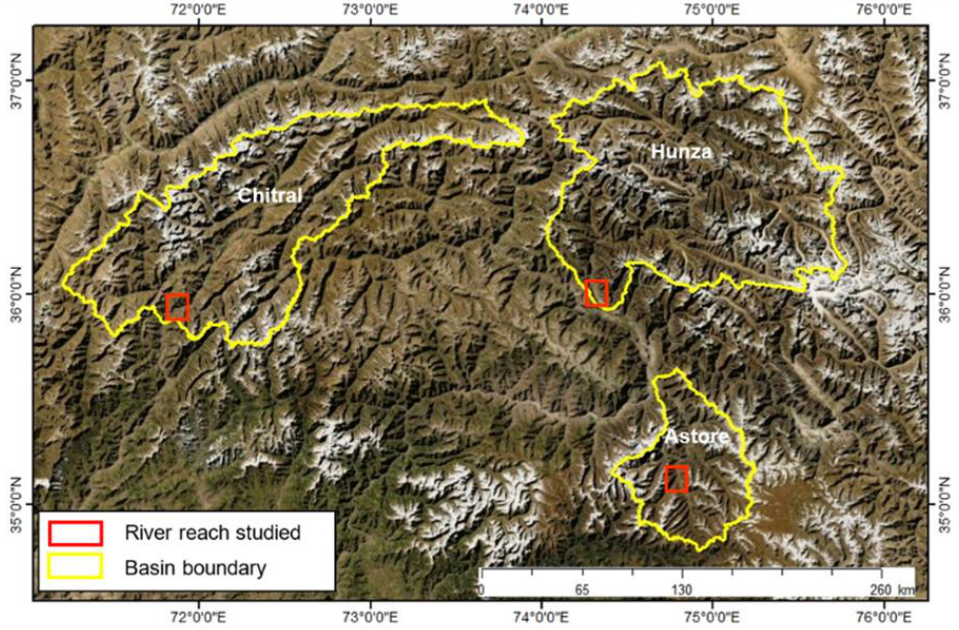
Figure 1. Basin boundaries of three study basins fed into HEC-RAS. The mapped flood areas are shown in red boxes.